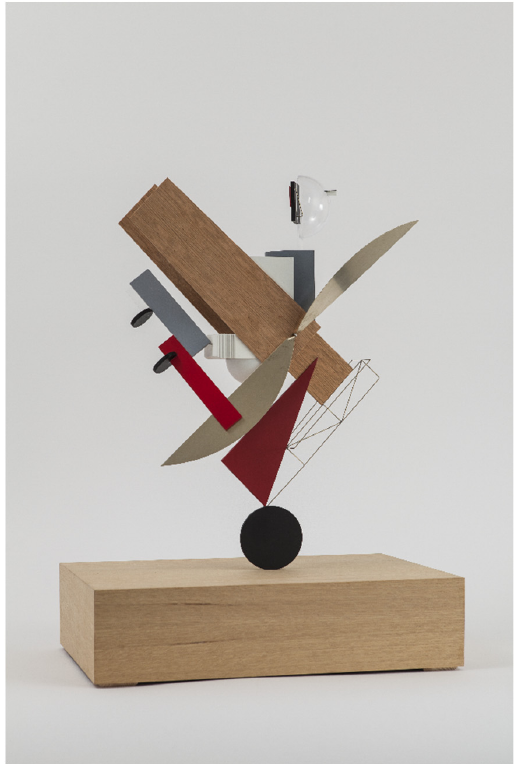
Figure 18. Model after El Lissitzky, ‘The Time Traveller’, 1923, construction by Henry Milner, 2009. Van Abbemuseum. Photo: Perry van Duijnhoven.